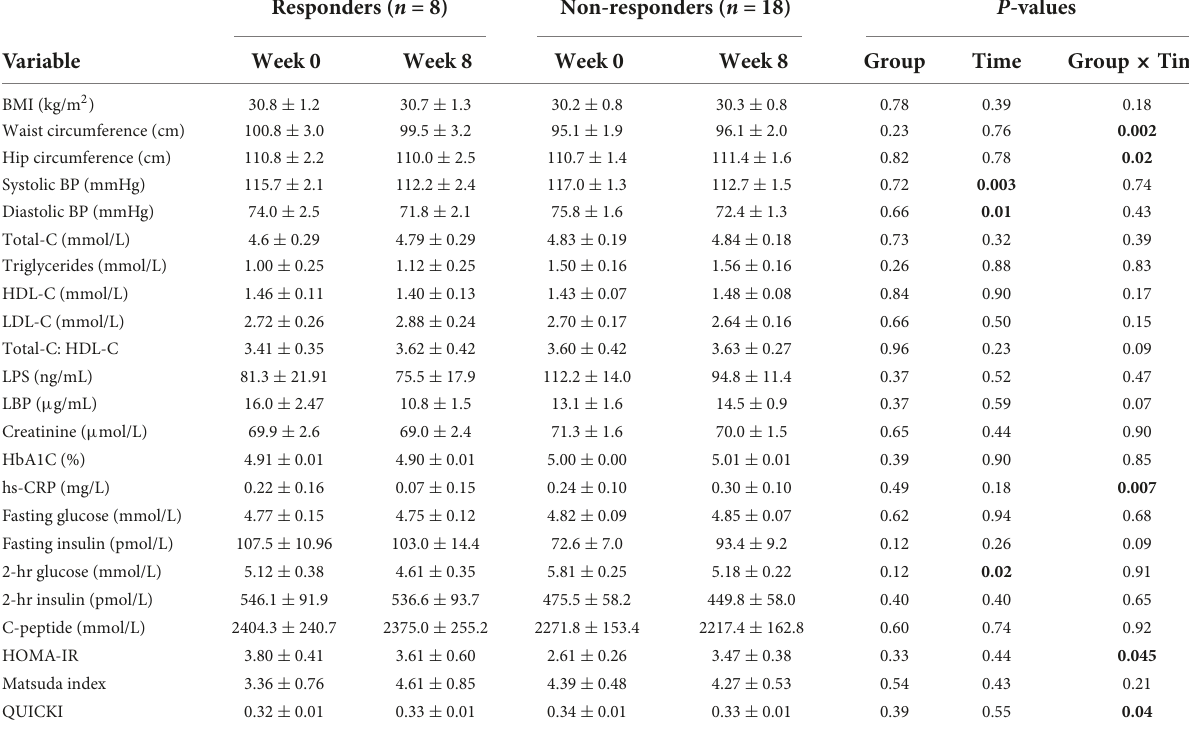
TABLE 1 Cardiometabolic outcomes over time within and between